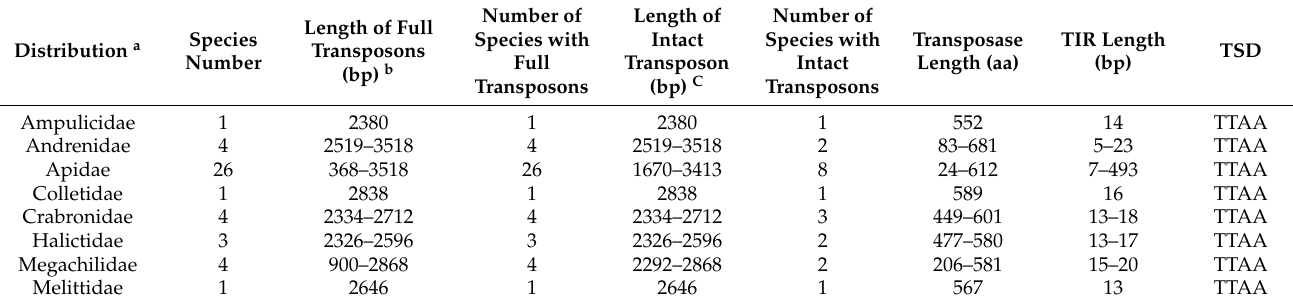
Figure 3. The logo fi gure of piggyBac ( PB ) Transposons’ TIR ( n = 40). The online website Welogo create logo images of the TIR sequences. The value 2 on the y axis stands for maximum possible frequency.